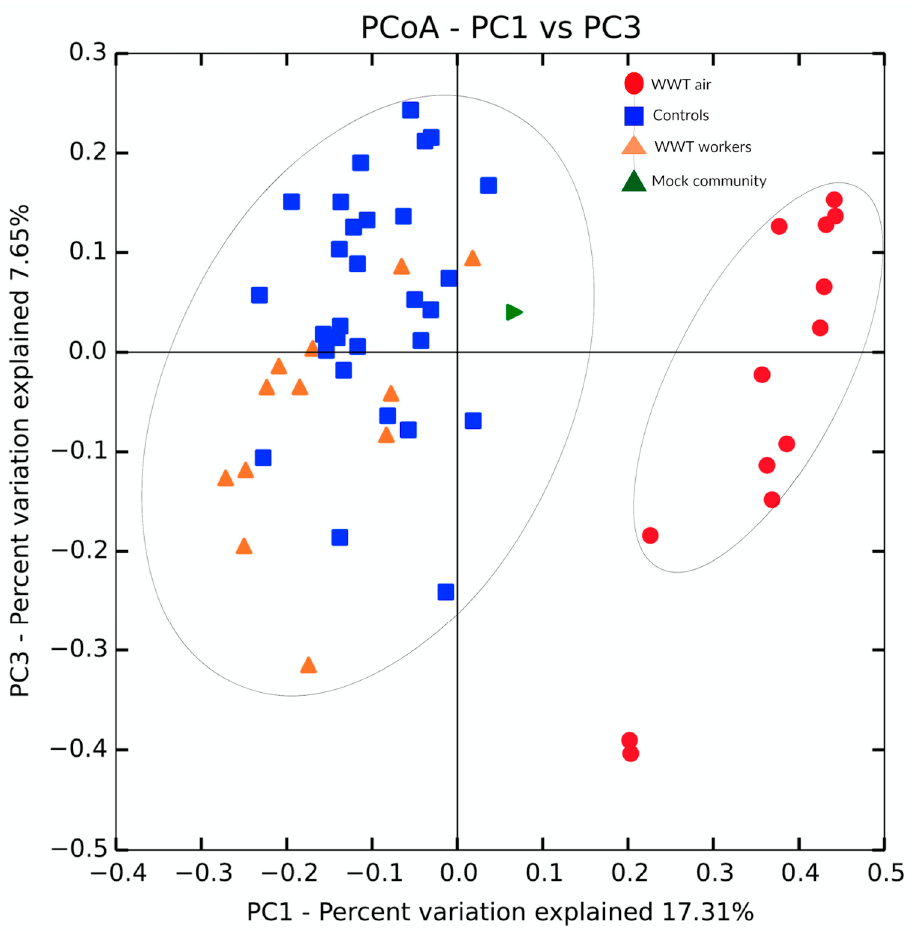
Figure 7. Principal coordinate analysis plot. The plot shows the distances for the microbiota of three groups of samples: nasopharynx samples from wastewater workers and from non-exposed controls and bioaerosols from Wastewater Treatment Plants (WWTPs). The pairwise distances were calculated using the weighted UniFrac distance metric.